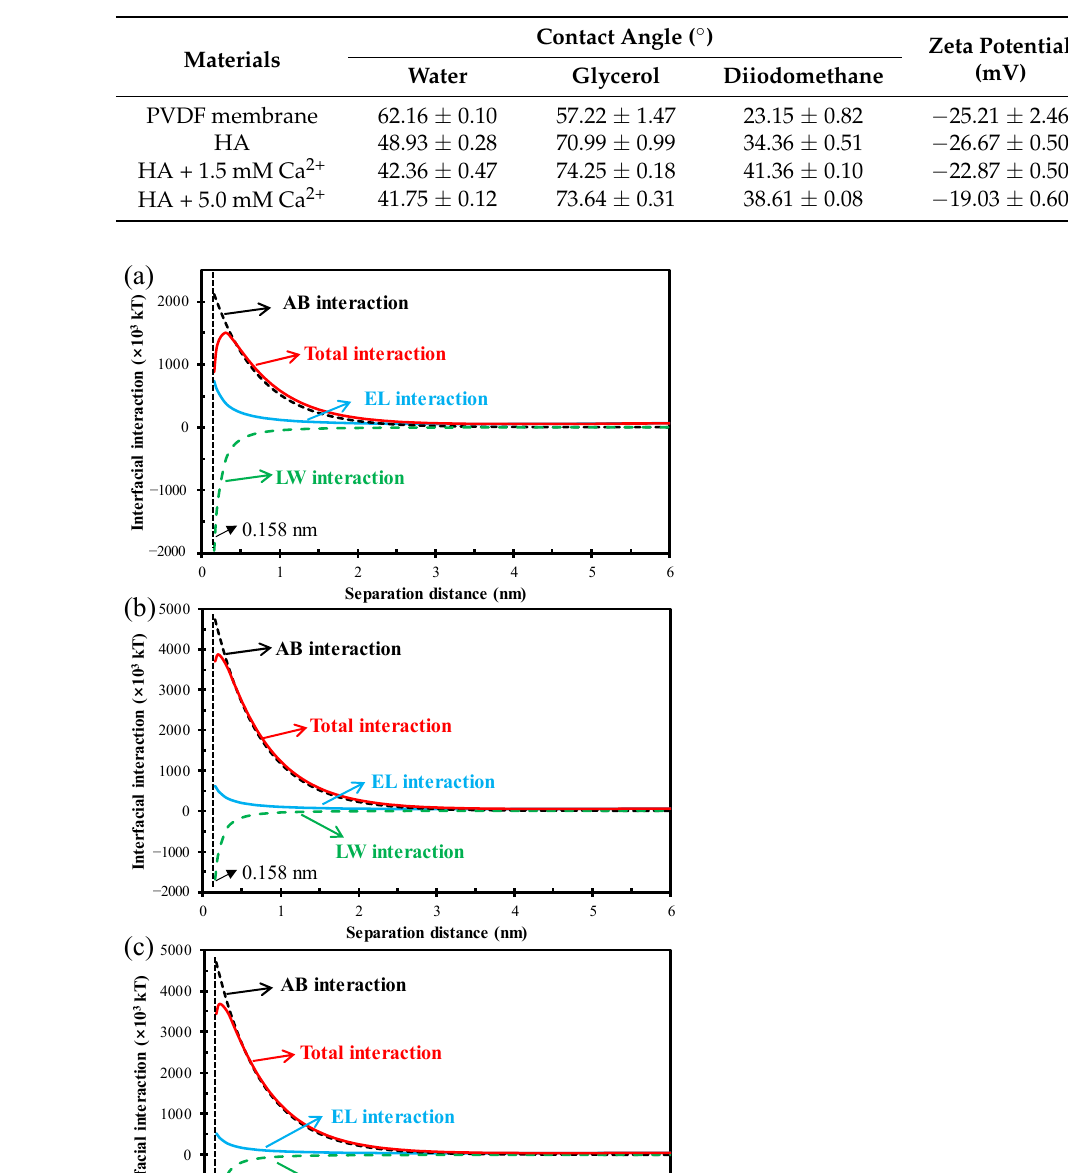
Table 1. Surface characteristics in terms of contact angle of three probe liquids and zeta potential of the PVDF membrane and HA solutions with different Ca 2+ concentration.